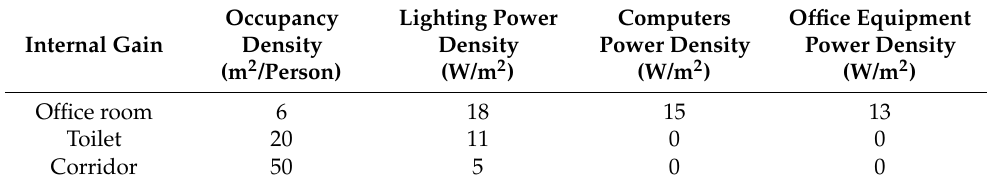
Table 2. Details of internal gains including occupancy, lighting, computer, and office equipment